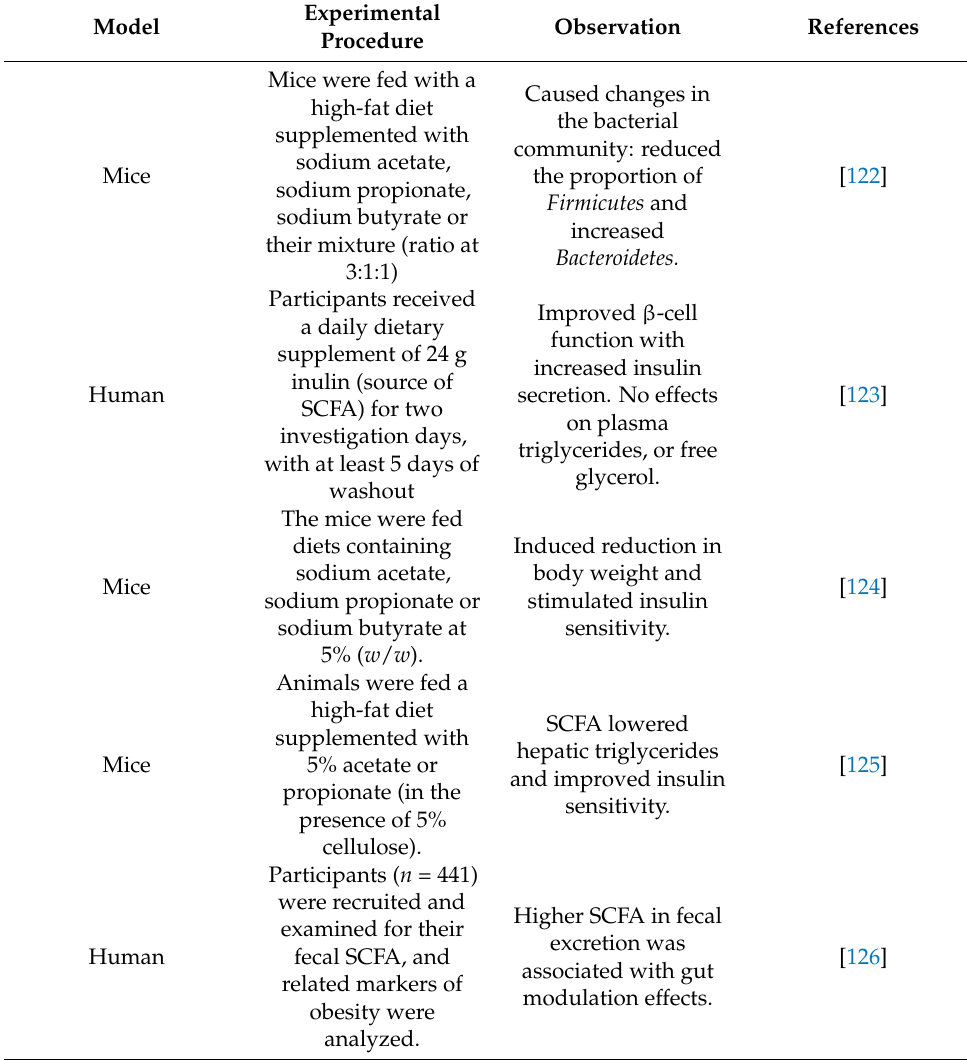
Table 5. Studies elucidating the anti-obesity effects of short-chain fatty acids (SCFA) in animal and human